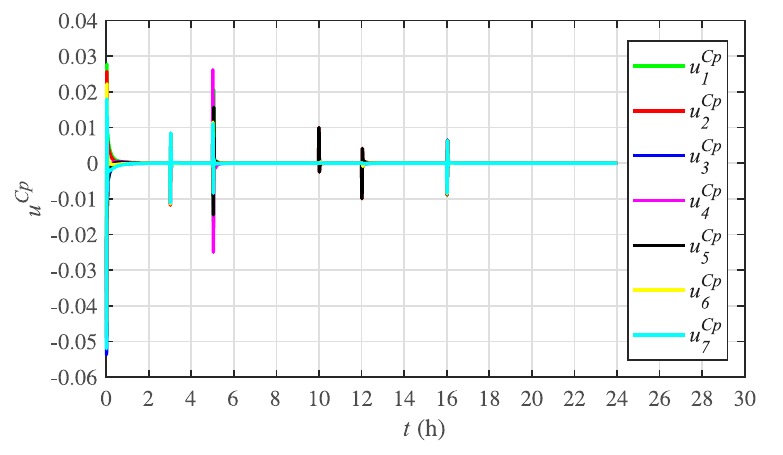
Fig 33. Production costs control efforts under case